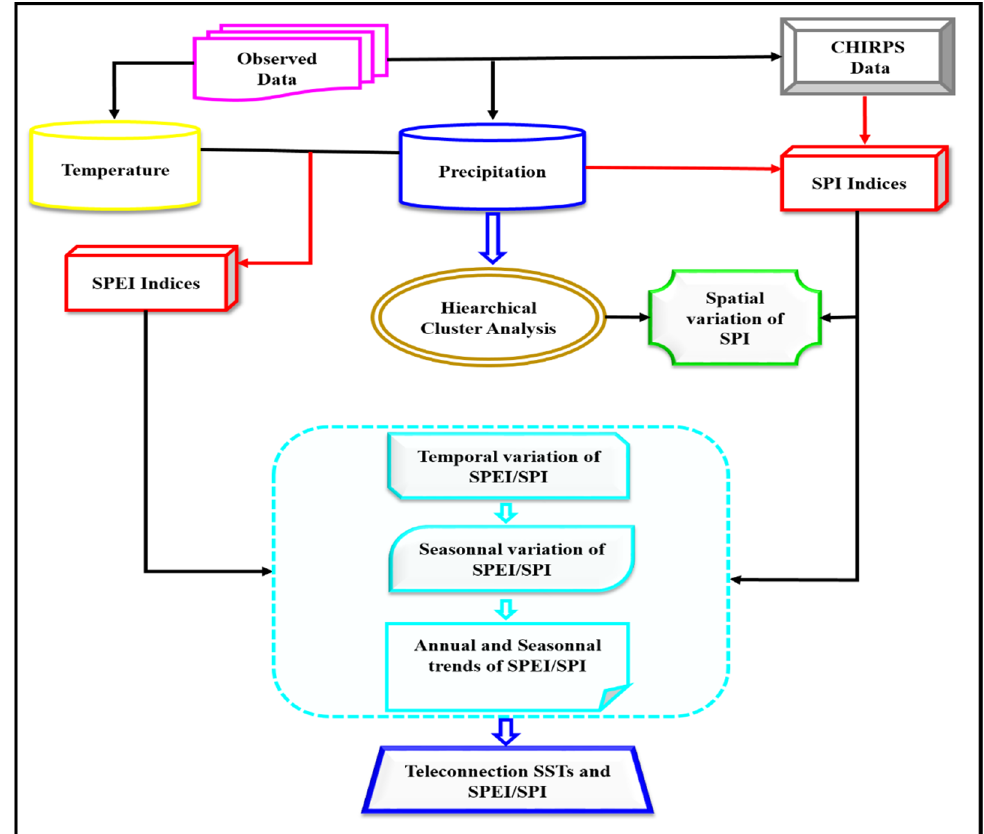
Figure 2. Flowchart of the research methodology.